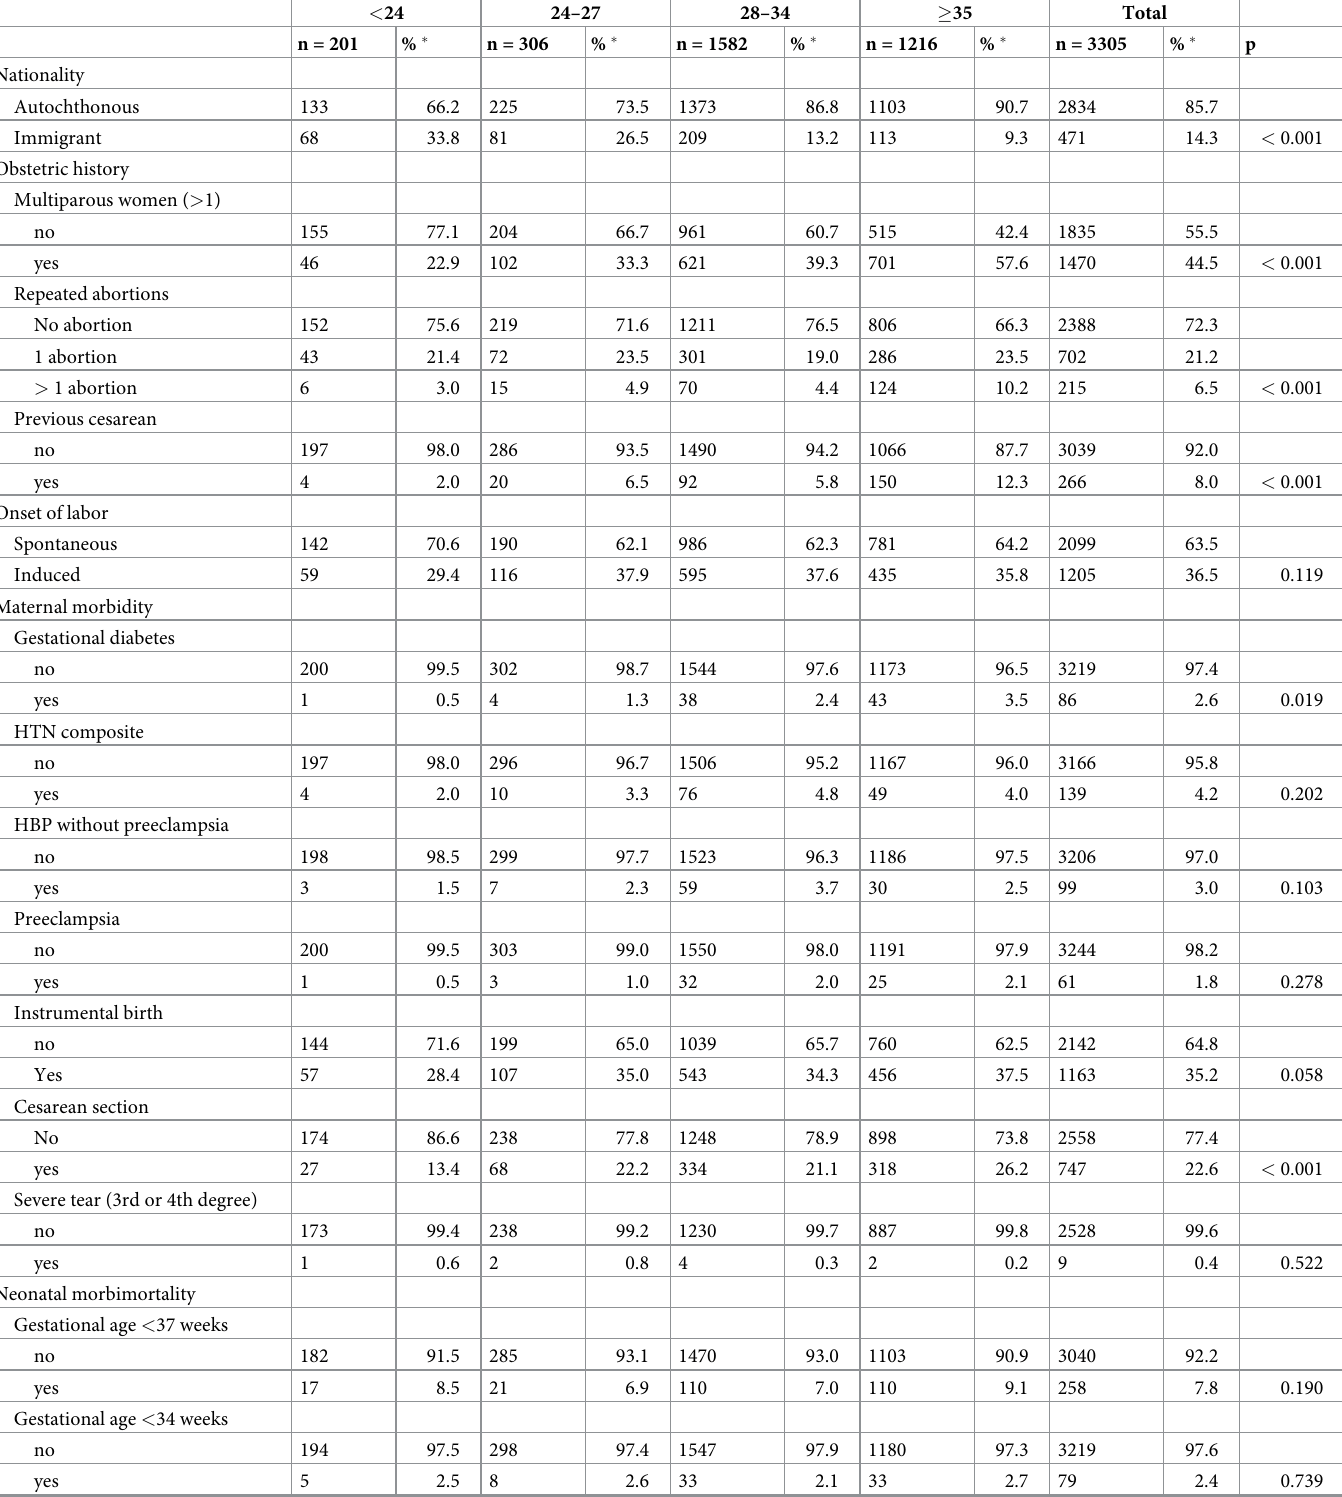
Table 1. General characteristics of the population under study according to the maternal age at the time of